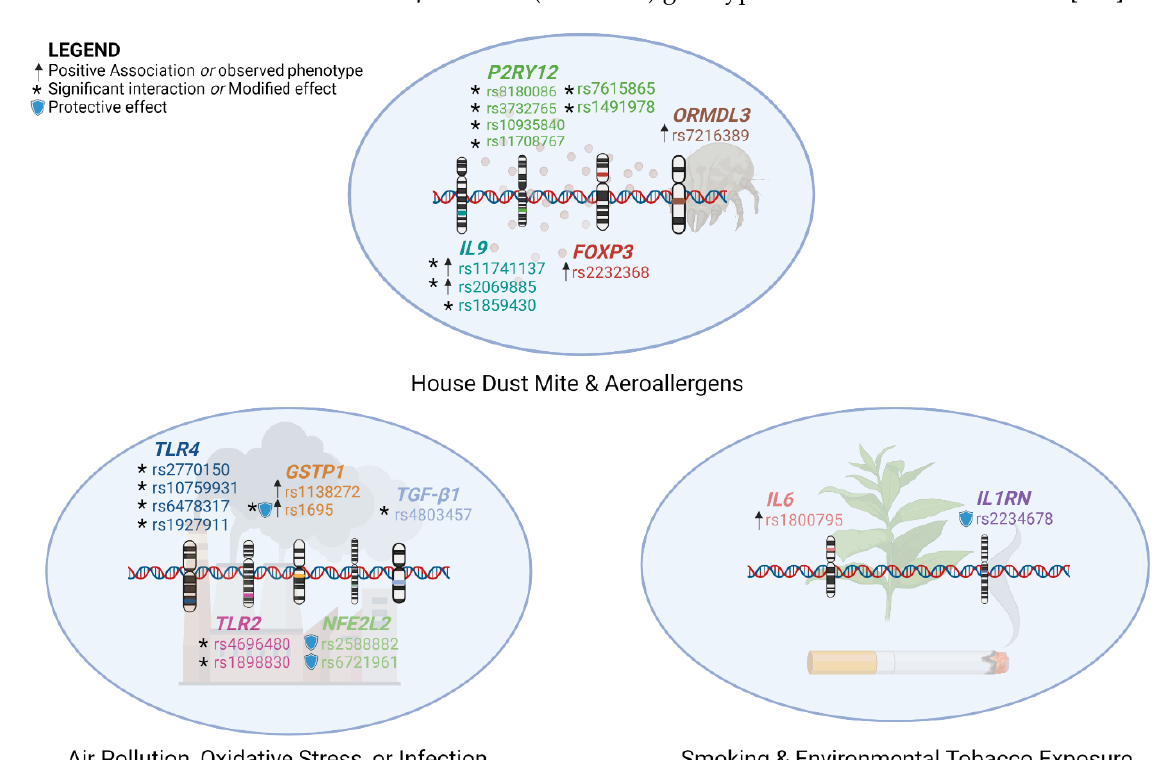
Figure 4. Gene-environmental factor interactions related with modified effects, susceptibility, complications, symptoms, or development of asthma, or asthma exacerbations. SNPs with more than one symbol may demonstrate multiple effects, or may differ depending on genotype, allele pairing, or type of allele (variant vs. wild-type, major vs. minor carrier).